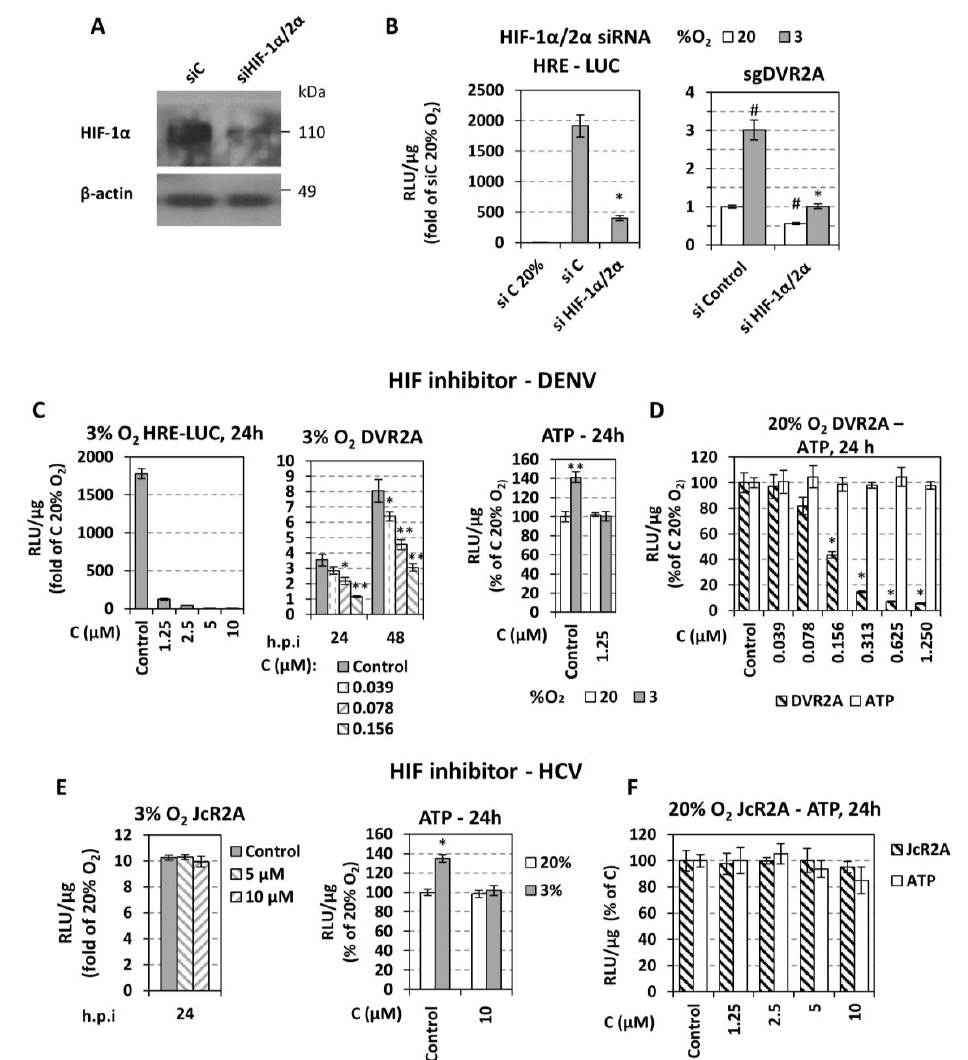
Figure 6. HIF downregulation impairs the replication of DENV but not HCV. ( A , B ) Huh7 cells were co-transfected with a mixture of siRNAs targeting HIF-1 α and HIF-2 α (20 nM each) or a control siRNA (40 nM) and the 9 × HRE-Luc construct, or the mixture of siHIF-1 α /2 α (or the control siRNA) and subgenomic sgDVR2A (sgDV). ( A ) Western blot analysis of endogenous HIF-1 α protein (top) and β -actin (bottom) of cells incubated at 3% O 2 for 24 h. β -actin served as loading control. ( B ) HRE-dependent F-Luc (left) and sgDVR2A-dependent R-Luc (right) activities from cells incubated at 20% or 3% O 2 for 24 h were measured and expressed as RLU/ µ g of total protein amount. Values were normalized to the reporter activity detected in cells cultured at 20% O 2 . * p < 0.001 vs. si control cells at 3% O 2 , # p < 0.001 vs. si control cells at 20% O 2 (Student’s t -test). ( C , D ) Huh7 cells pre-incubated at 20% or 3% O 2 were transfected with the 9 × HRE-Luc construct or inoculated with DVR2A (MOI 0.01) for 4 h. Subsequently, cells were treated with serial dilutions of the HIF-1 inhibitor NSC-134754 and further incubated at the pre-incubation condition. Reporter activity was measured and expressed as RLU/ µ g of total protein amount. Values are expressed as ratio of the respective ones measured at 3% versus 20% O 2 (C left, middle), or as percentage of the ones from control-treated cells at 20% O 2 (C right, D). For panel C: * p < 0.01, ** p < 0.001 vs. control cells. For panel D: * p < 0.001 vs. control cells. ( E , F ) Huh7.5 cells were infected with the HCV reporter virus JcR2a (MOI = 1), treated with the HIF-1 inhibitor NSC-134754 and cultured as described for DENV ( C , D ). In all panels, bars represent mean values from at least three independent experiments in triplicate. Error bars indicate standard deviations. * p < 0.001 vs. control